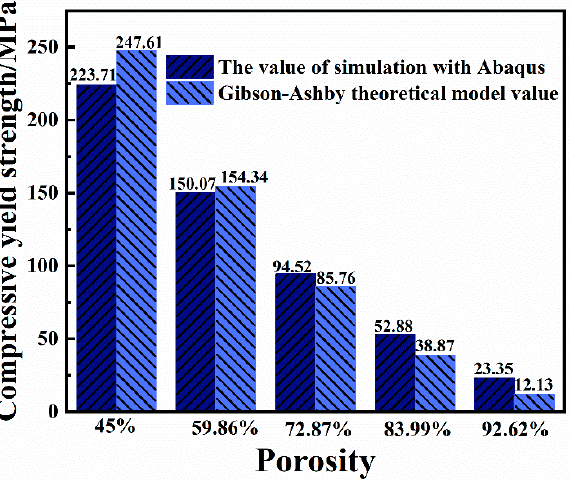
Figure 6. The compressive yield strength of each structure obtained by simulation calculation and formula calculation.